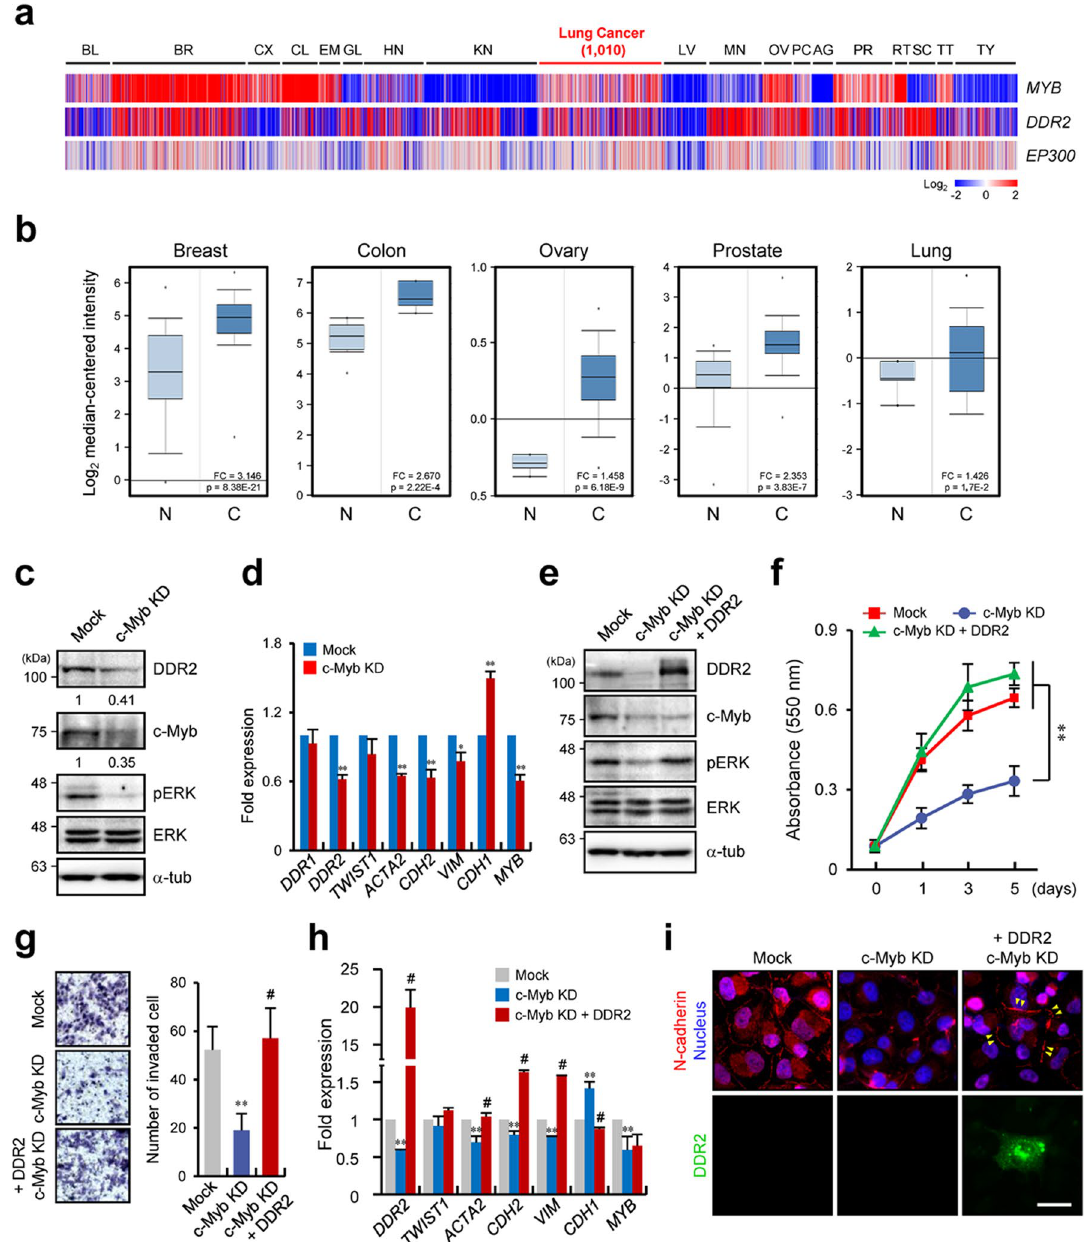
Figure 6. c-Myb is associated with lung cancer progression because of regulation of DDR2 expression. ( a ) Heat map representation of a TCGA pan-cancer RNA-Seq dataset from the Cancer Browser (Illumina HiSeq) showing the MYB , DDR2 , and EP300 expression levels in various cancer tissues. BL, bladder; BR, breast; CX, cervix; CL, colon; EM, endometrium; GL, glioma; HN, head and neck; KN, kidney; LV, liver; MN, melanoma; OV, ovary; PC, pancreas; AG, adrenal gland; PR, prostate; RT, rectum; SC, sarcoma; TT, testis; TY, thyroid. ( b ) An Oncomine boxed plot showing MYB expression levels in human breast, colon, ovary, prostate, and lung normal and cancer tissues. N, normal; C, cancer. ( c ) Western blot analysis of DDR2, c-Myb, phospho (p)- ERK, and ERK in H1299 cells expressing mock or anti–c-Myb shRNA. KD: c-Myb knockdown. ( d ) qRT-PCR analysis of DDR1 . DDR2 , TWIST1 , ACTA2 , CDH2 , VIM , CDH1 , and MYB under the conditions shown in panel c. Data represent the mean of three independent experiments ± SEM. * P < 0.05, ** P < 0.01. ( e ) Western blot analysis of DDR2, c-Myb, pERK, and ERK in H1299 cells expressing mock or anti–c-Myb shRNA, or analysis of ectopically expressed DDR2 in H1299 cells expressing anti–c-Myb shRNA. ( f , g ) Quantification of proliferation ( f ) and invasion ( g ) shown by H1299 cells under the conditions shown in panel e. Data represent the mean of three independent experiments ± SEM. * P < 0.05, ** P < 0.01. ( h ) qRT-PCR analysis of DDR2 , TWIST1 , ACTA2 , CDH2 , VIM , CDH1 , and MYB under the conditions shown in panel e. Data represent the mean of three independent experiments ± SEM.; * P < 0.05, ** P < 0.01, # P < 0.01 as compared to c-Myb knockdown groups. ( i ) Immunostaining of N-cadherin and nuclei in H1299 cells under the conditions shown in panel e. The GFP signal indicates the cells ectopically expressing